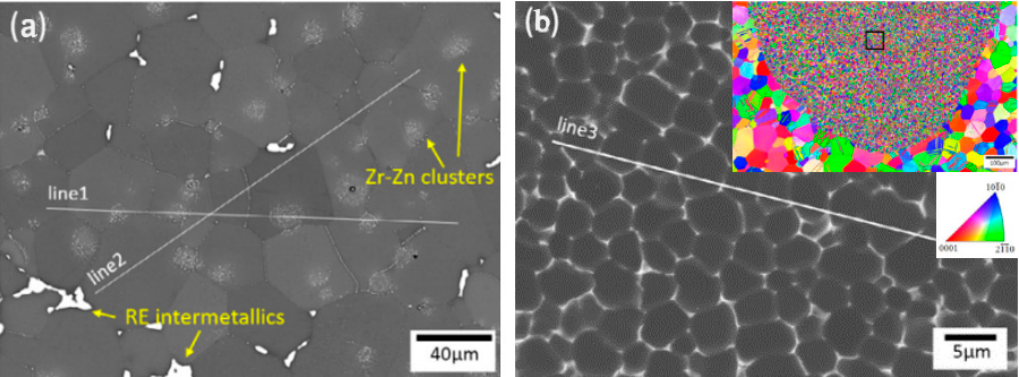
Figure 7. SEM BSE images of the laser-remelted Mg-3Nd-1Gd-0.5Zr alloy showing the microstructure of: ( a ) the substrate; ( b ) the melt pool, the cross-section EBSD analysis of which is included as an inset in the upper-right corner [58]. Reprinted with permission from ref. [58]. Copyright 2020 Elsevier.